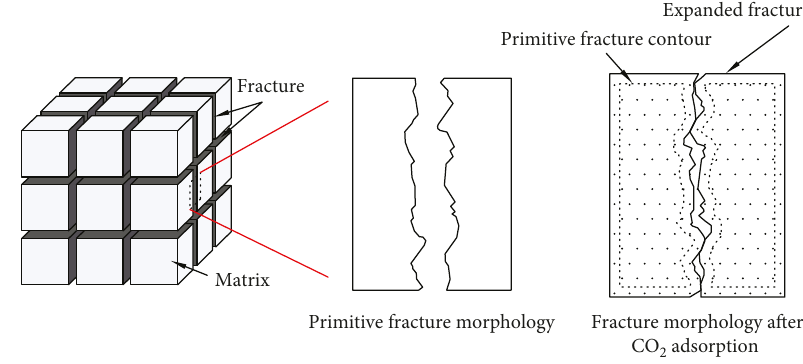
Figure 11: Expansion deformation of coal after adsorbing CO